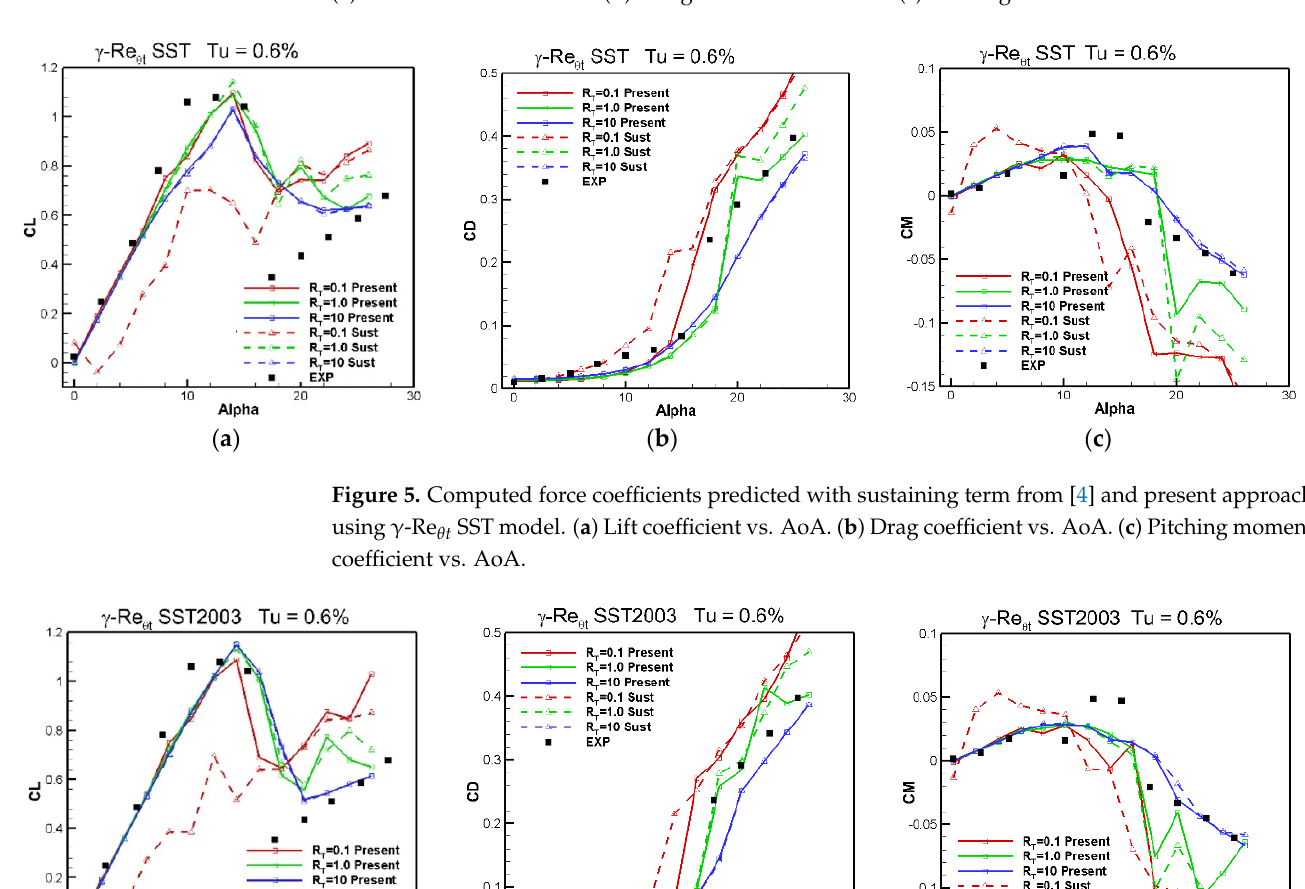
Figure 5. Computed force coefficients predicted with sustaining term from [4] and present ap- proach using γ -Re θ t SST model. ( a ) Lift coefficient vs. AoA. ( b ) Drag coefficient vs. AoA. ( c ) Pitching moment coefficient vs. AoA.